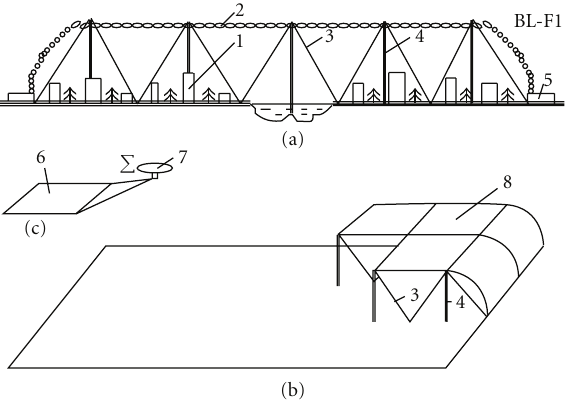
Figure 6: (a) Design of AB Blanket from the transparent film over city and (b) building the AB Dome from parts of the AB Blanket.